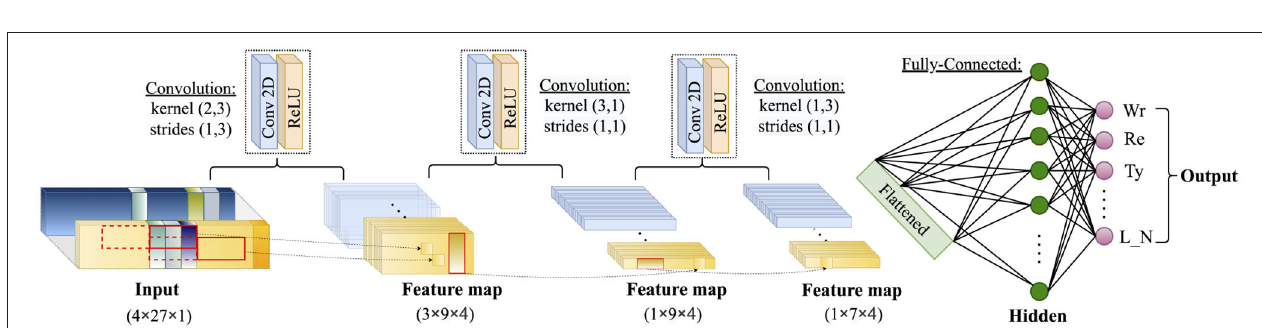
FIGURE 2 | The structure of the convolutional neural network (CNN) models. The 8-s nine-channel data streams were transformed into a 4 shown in the figure) 2D matrix to input into the network. There are three variants, where CNN(1) uses the first convolutional layer, CNN(2) uses the first two convolutional layers, and CNN(3) uses all the three convolutional layers.